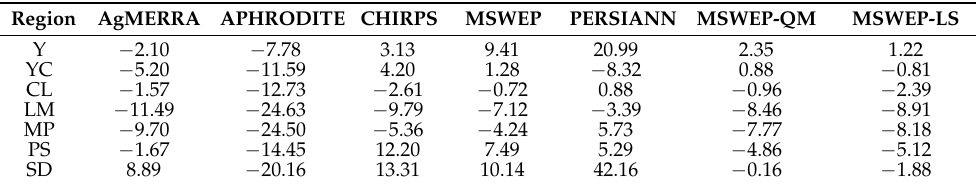
Table 5. BIAS (%) of five precipitation products and two corrected precipitation products against gauge observations over seven sub-regions at daily